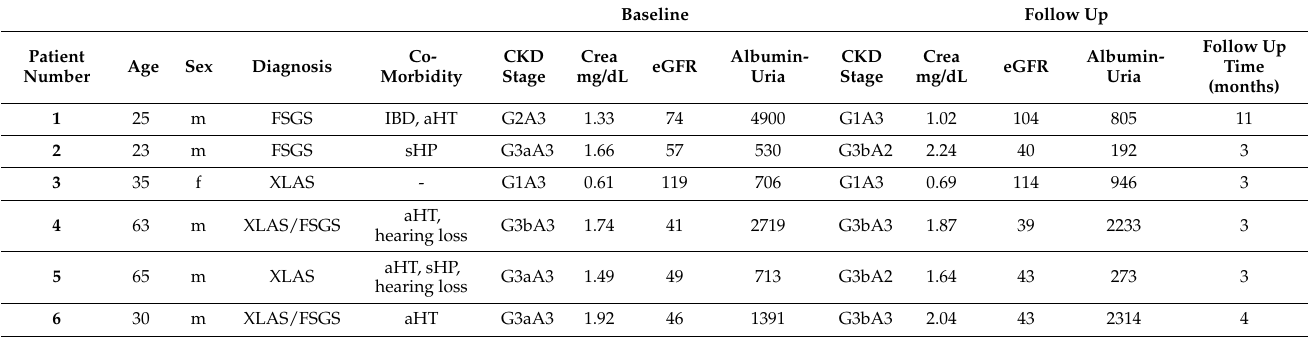
Table 1. Clinical characteristics of